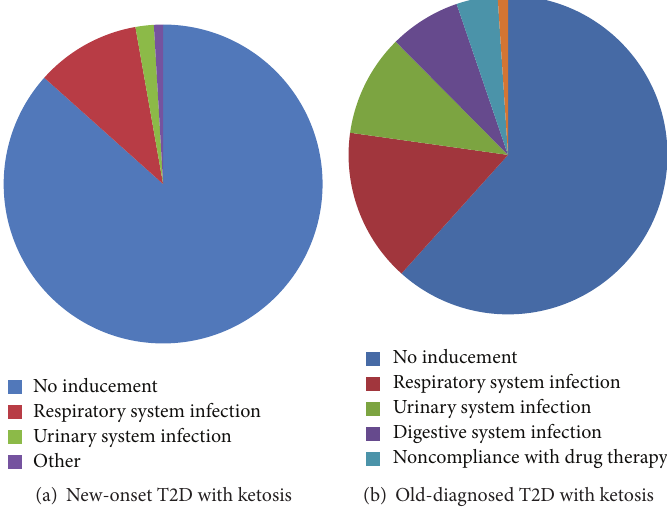
Figure 1: Potential factors precipitating ketosis in T2D patients.